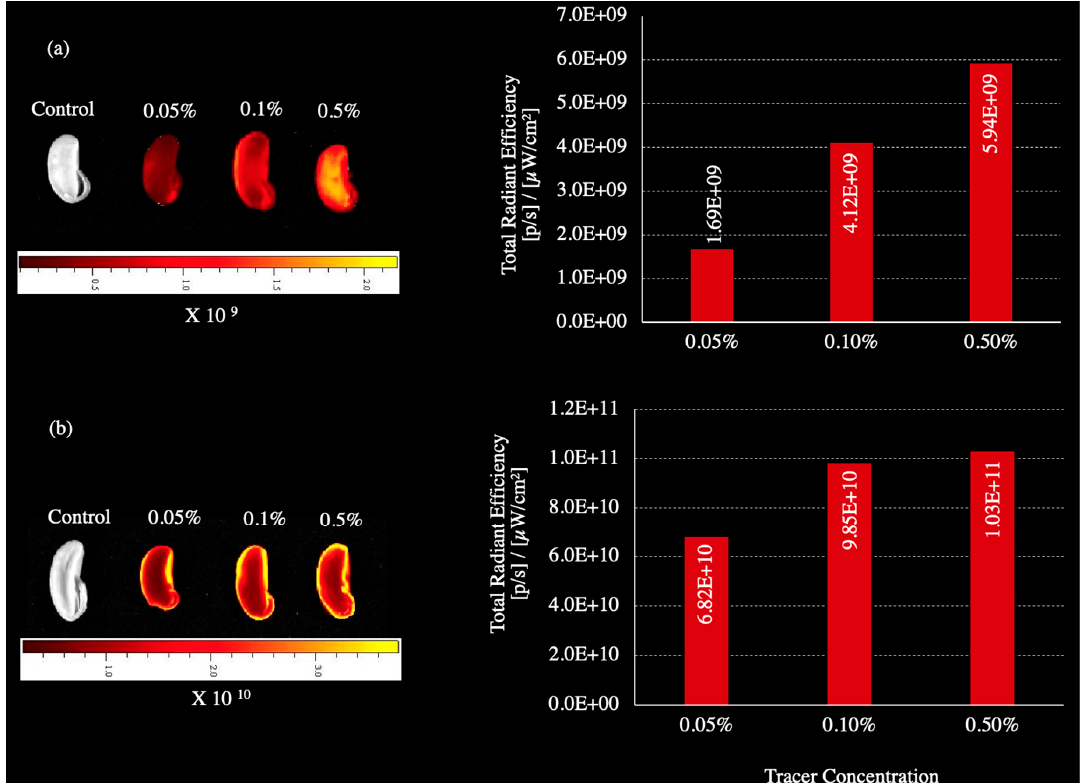
Figure 3. Rhodamine B and rhodamine 800 uptake in yellow soybean seed variety TMG 4185 applied at different concentrations of ( a ) rhodamine 800, ( b ) rhodamine B. Imaging was done under the in vivo imaging system (IVIS).